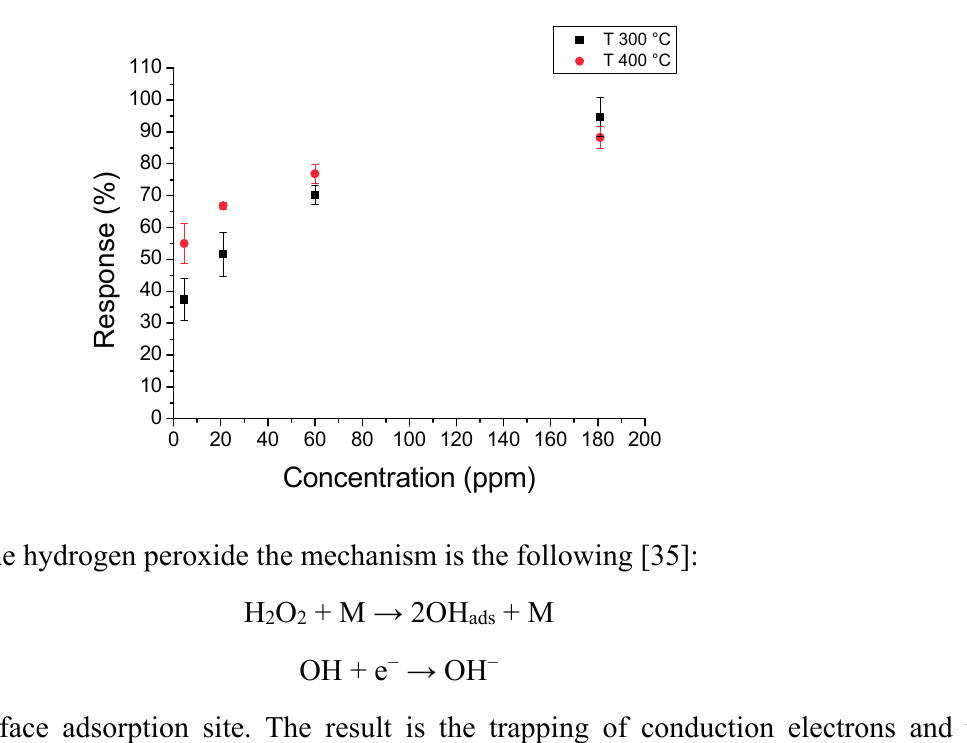
Figure 9. Response of a nanofiber sensor with 180 s deposition time and 450 °C annealing temperature to hydrogen peroxide at 300 °C and 400